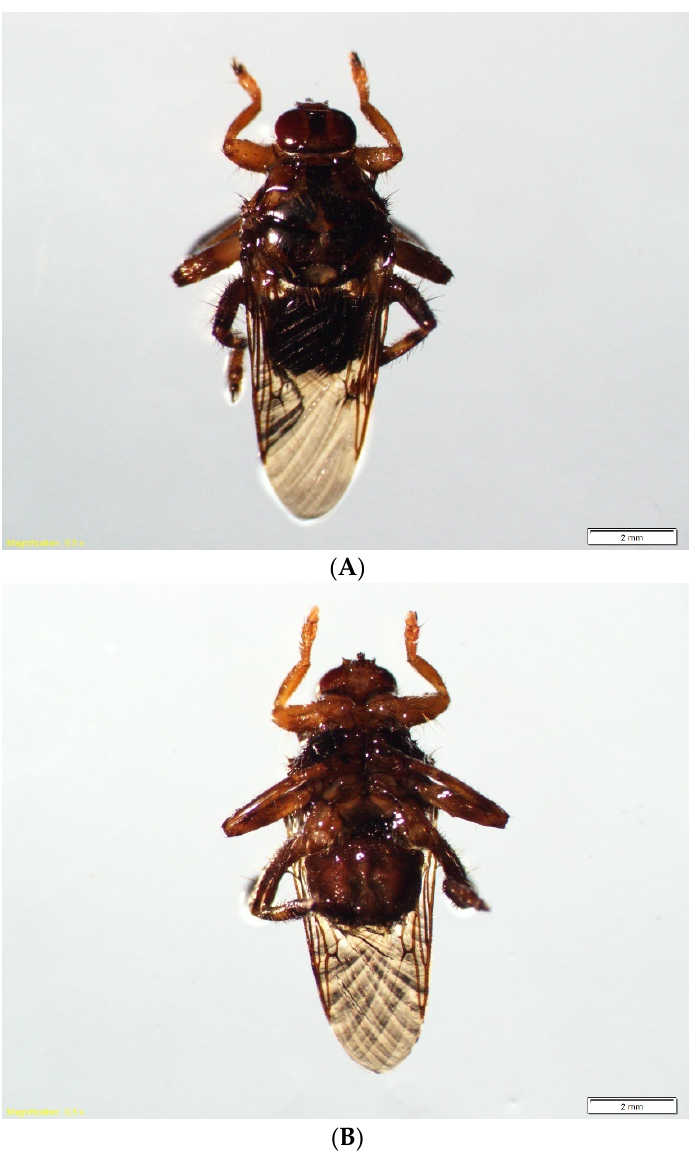
Figure 1. Hippobosca equina male: ( A ) dorsal view; ( B ) ventral view (photos by Weronika Ma ś lanko).